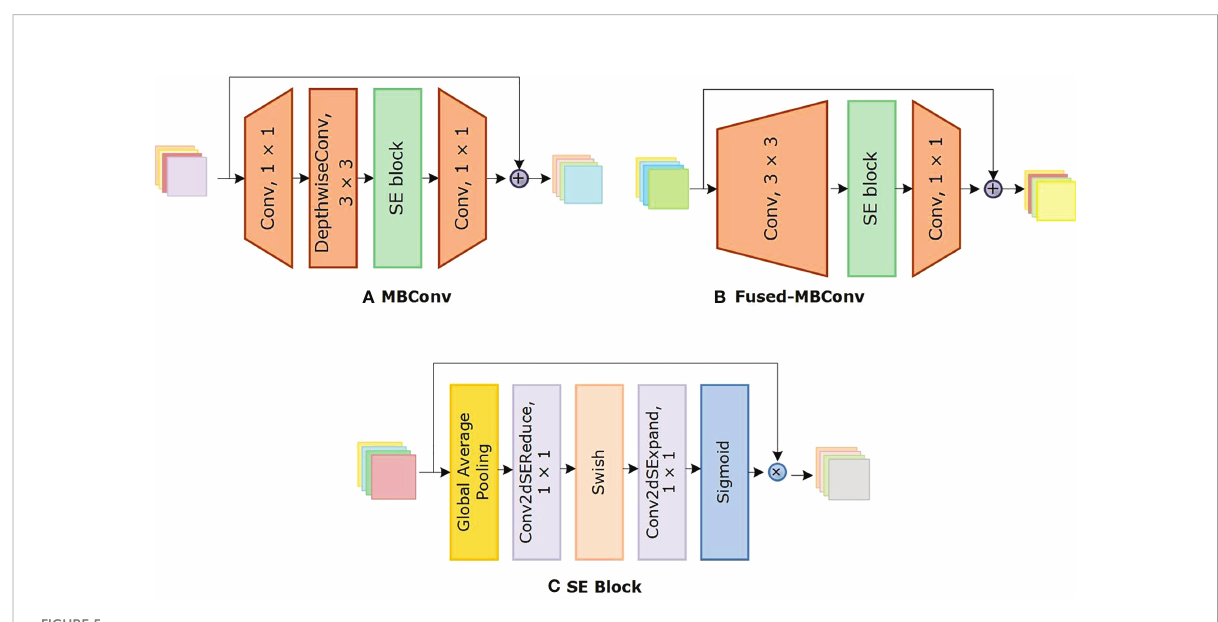
FIGURE 5 Structure of MBConv, Fused MBConv, and the SE